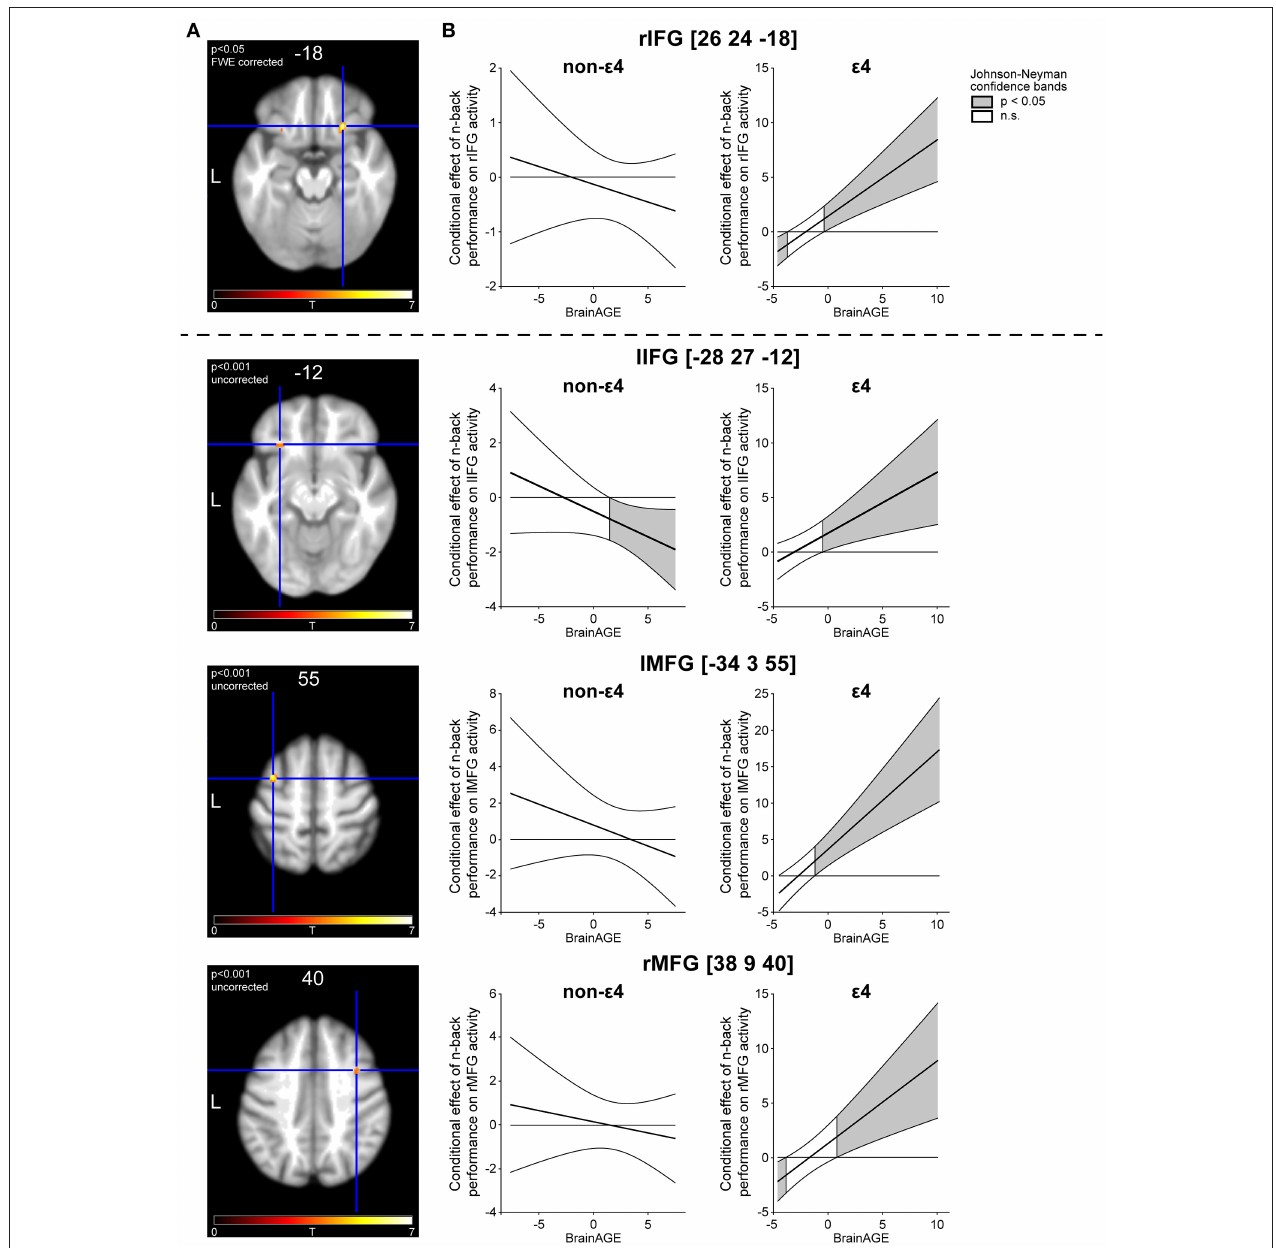
FIGURE 3 | Three-way interaction of task performance, BrainAGE and APOE variant. (A) Activation peaks in bilateral inferior frontal as well as in bilateral middle frontal gyrus. Z-coordinates of the respective peak are depicted above the slices. (B) Johnson–Neyman (JN) confidence bands depicting the relationship of task performance and brain activation as a conditional effect across the whole range of the first moderator variable BrainAGE. To visualize the three-way interaction, JN bands are depicted separately for the second moderator APOE variant ( ε 4 vs. non- ε